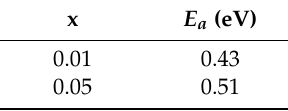
Table 5. Activation energy of the LaFe 1 − x Zr x FeO 3 (x = 0.01, 0.05) ceramics.